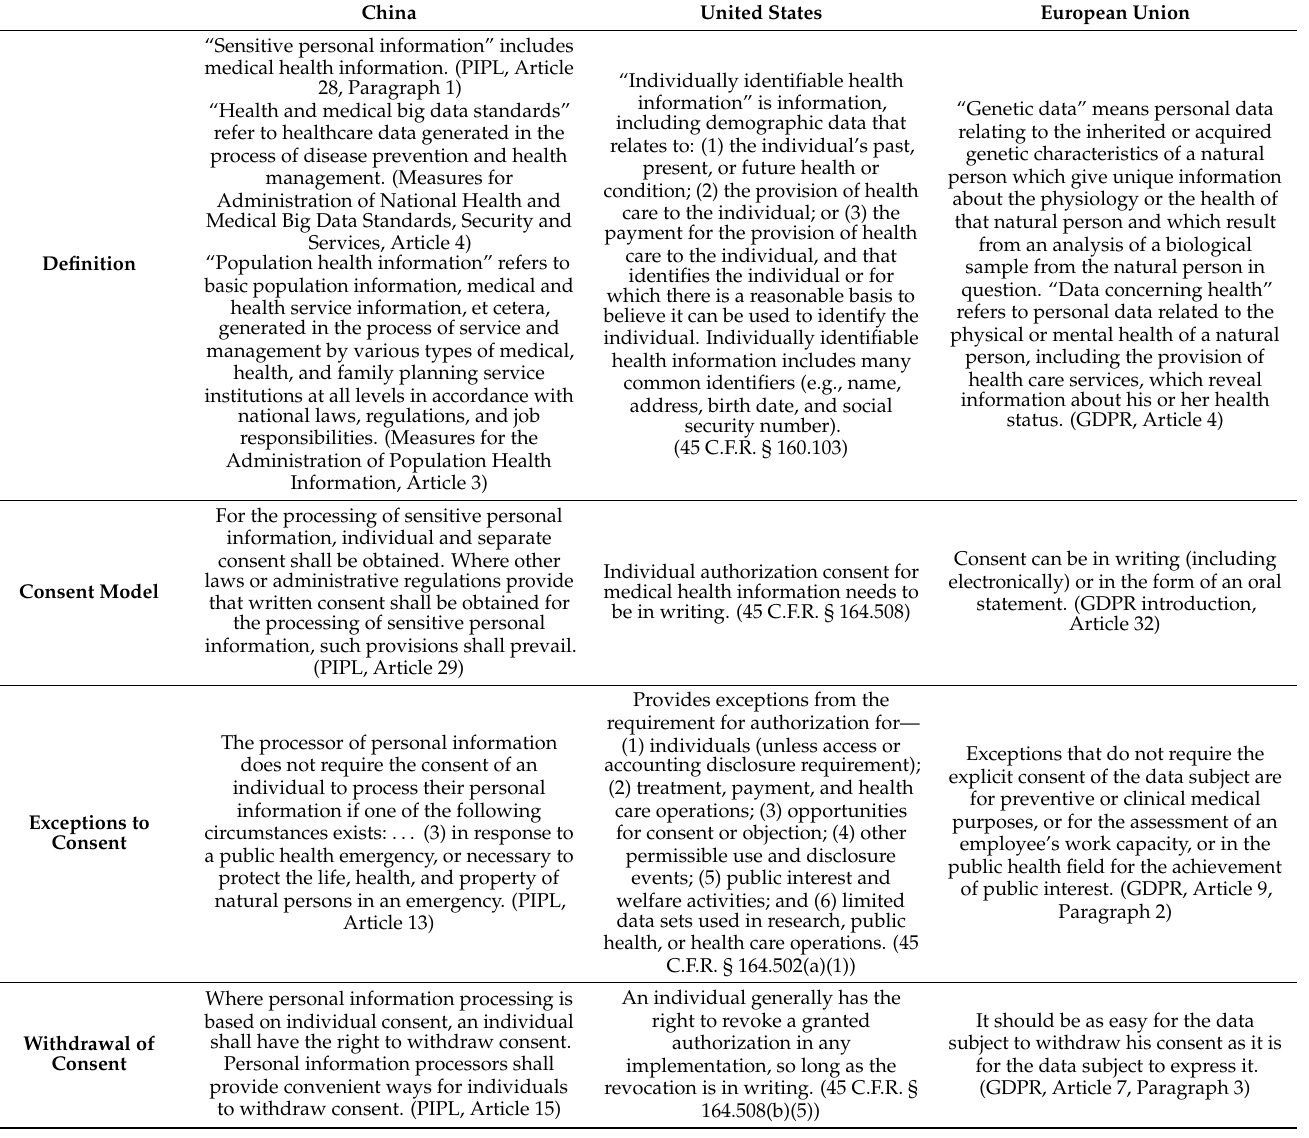
Table 2. Differences between China, the U.S., and EU in regulating healthcare information. China United